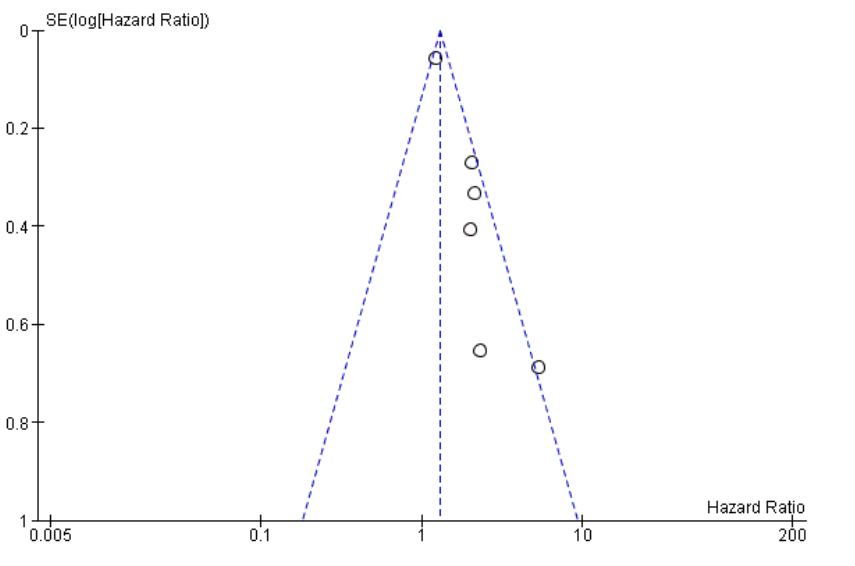
Figure 6. Funnel plot for the primary outcome; I 2 = 60%.